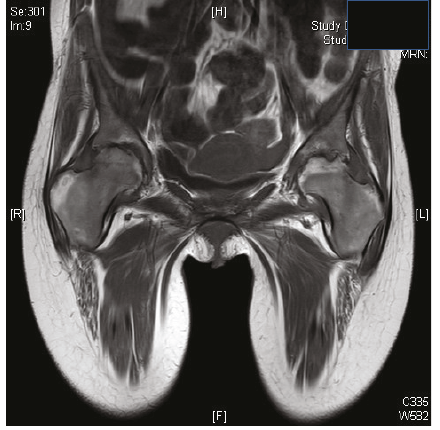
Figure 4: MRI of the hips at age